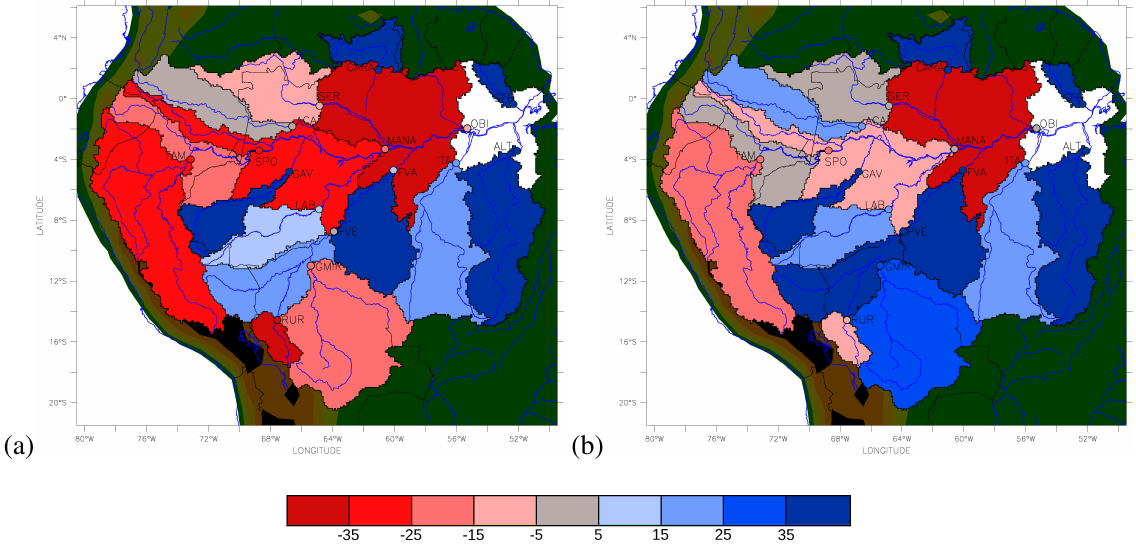
Fig. 9. Mean relative error of Qmean (%) between simulations – (a) ORCH1, (b) ORCH2 – and observation over the time period 1980–2000. The color indicates the sign of the error: red is negative error, blue is positive error and grey is very low error. The error is represented for the different stations (colored circles) and their associated sub-basins (same color than the corresponding station). Five residual basins are also represented: SPO*, MANA*, OBI*, PVE* and FVA*. Qmean of each residual basin is the difference between the downstream and the upstream station(s) Qmean. Thus, the color of the residual basin can be different from the color of the downstream station. For topographic scale, see Fig. 2.